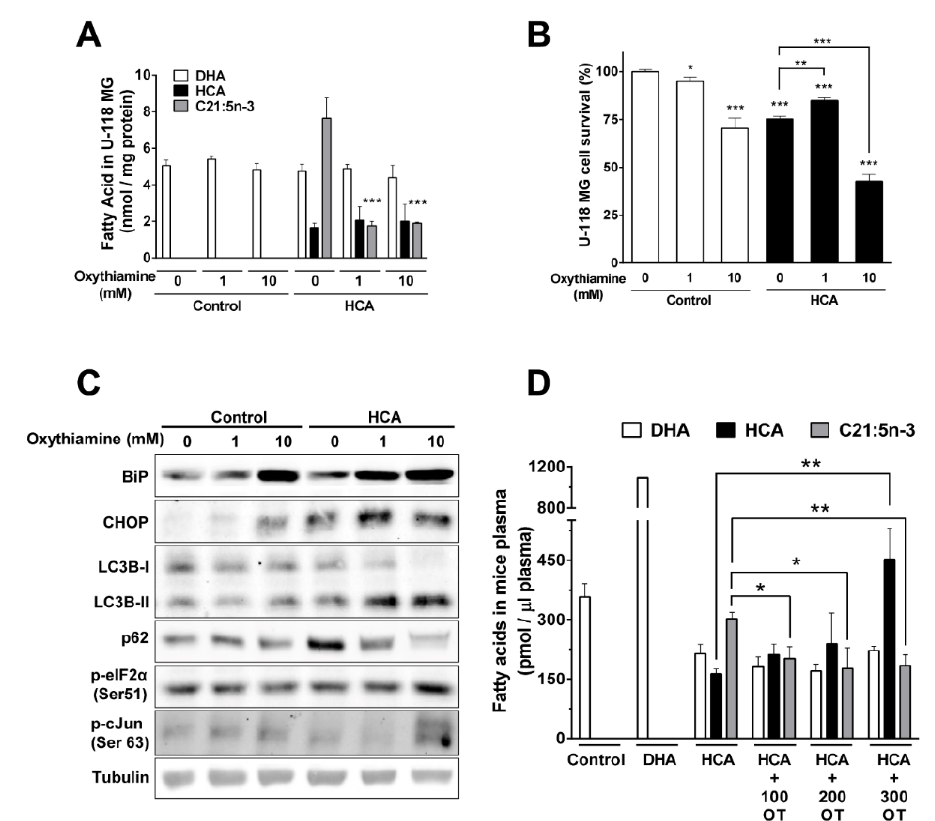
Figure 7. The α-oxidation of HCA to C21:5n-3. ( A ) U-118 MG cells were pretreated with oxythiamine (OT, 1 or 100 mM) for 1.5 h before exposure to HCA (150 µM) for 48 h, and the cell’s lipids were extracted and quantified by GC (all bars correspond to the mean ± SEM values of at least 3 independent experiments). ( B ) Effect of OT on the survival of cells treated for 48 h with HCA (bars correspond to the mean ± SEM values of 3 independent experiments performed in triplicate), and ( C ) representative immunoblots of the effect of OT and HCA on ER stress/UPR and autophagy markers in U-118 MG cells. ( D ) The quantity of fatty acids in the plasma of mice treated with OT (100, 200, or 300 mg/ kg, p.o., daily) and HCA (200 mg/kg, p.o., daily) for 7 days (the bars correspond to the mean ± SEM values of at least 3 plasma mice samples). Student’s t-test: *** p < 0.001, ** p <